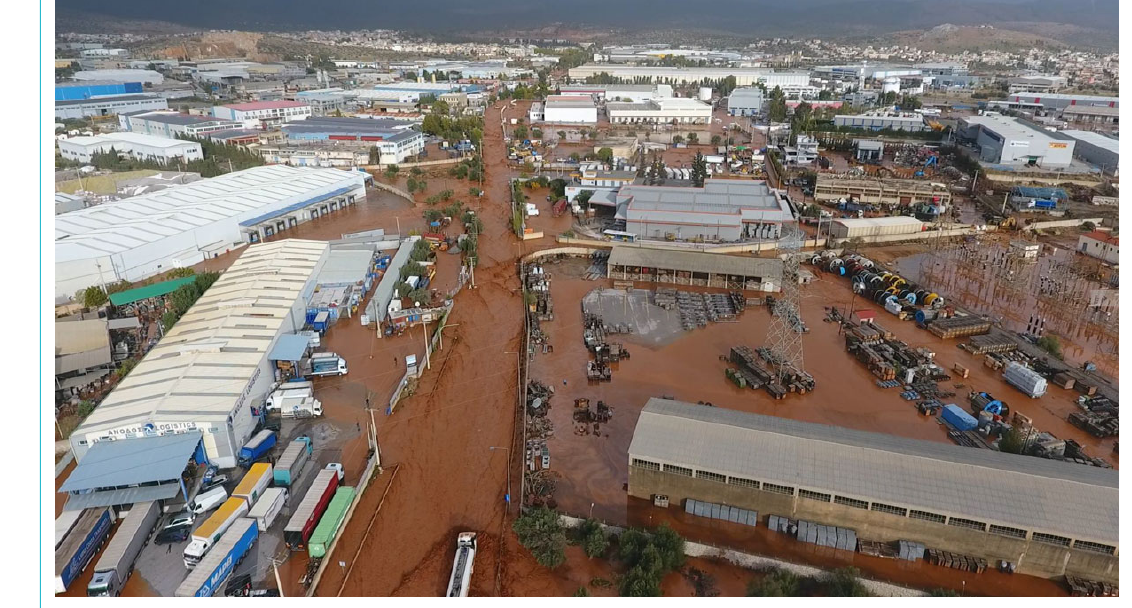
Figure 2: Scanning the industrial zone of west Athens after the lethal floods of Mandra (2017). From reference